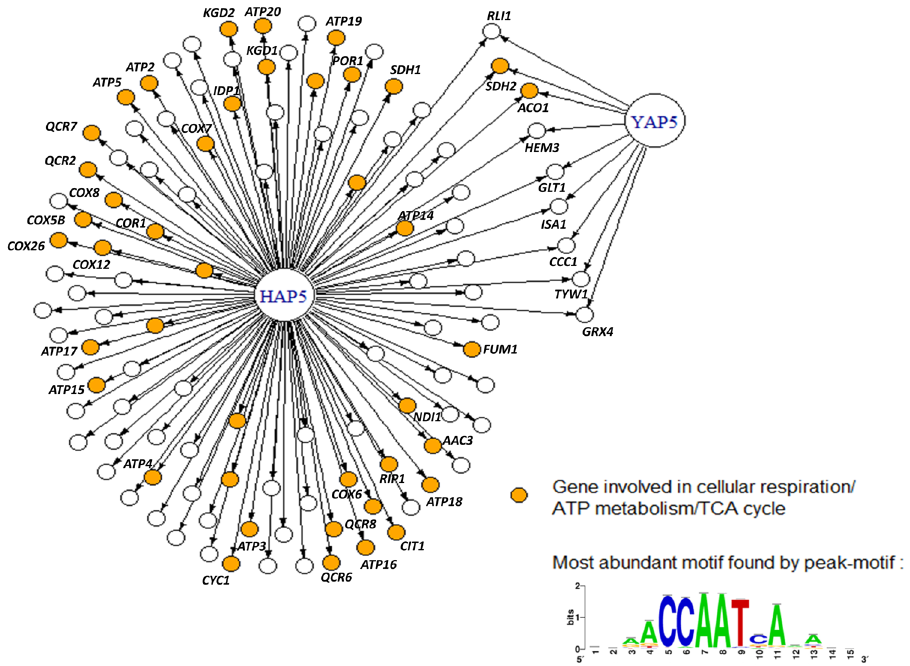
Figure 1. The Hap5 network in Candida glabrata . An arrow indicates a potential regulatory interaction based on ChIP-seq. The color of the targets indicates their belonging to respiratory pathways (yellow) or not (white). The most enriched DNA motif in ChIP peaks is represented at the bottom right. The Yap5 data are from ref. 29. The gene names indicated are those of the S. cerevisiae orthologs (according to the CGD database, www. candidagenome.org). For the sake of clarity, only the names of the genes which are discussed in the main text are